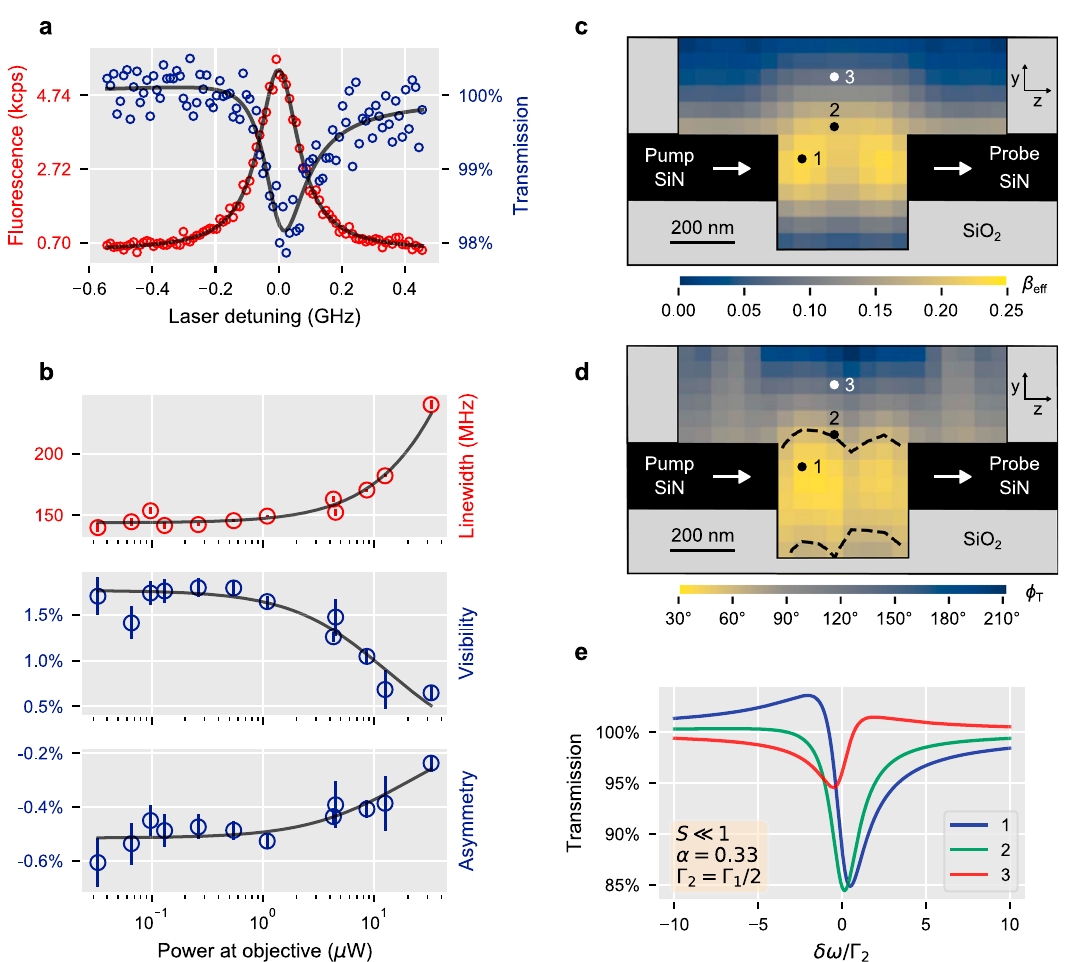
Fig. 3 Coherent characterisation of a coupled single molecule by extinction spectroscopy. a Experimental data. Red circles: red-shifted fl uorescence emerging from the gap, fi tted with a Lorentzian curve. Blue circles: transmission at 785 nm observed through the output grating, normalised and fi tted according to Eq. (11). b Plots of full width at half maximum (FWHM) linewidth, visibility ( V ) and asymmetry ( q ) as a function of the pump power. Error bars signify one standard deviation from fi tting the transmission at each power. c , d Computation of the coupling ef fi ciency β eff and propagation phase difference ϕ T for a dipole along the x direction, placed in the mirror symmetry plane of the structure. e Normalised transmission spectrum from Eq. (11) expected for lifetime-limited DBT molecules placed inside the channel, at positions 1 – 3 shown in c and d output grating, as indicated in Fig. 2c. The data are plotted in Fig. 3a as open circles in red and blue for the fl uorescence and transmission, respectively. A solid line shows the least-squares fi t of a Lorentzian to the fl uorescence data, which gives us the ffiffiffiffiffiffiffiffiffiffiffi p linewidth, 2 Γ 1 þ S (full width at half maximum (FWHM)). 2